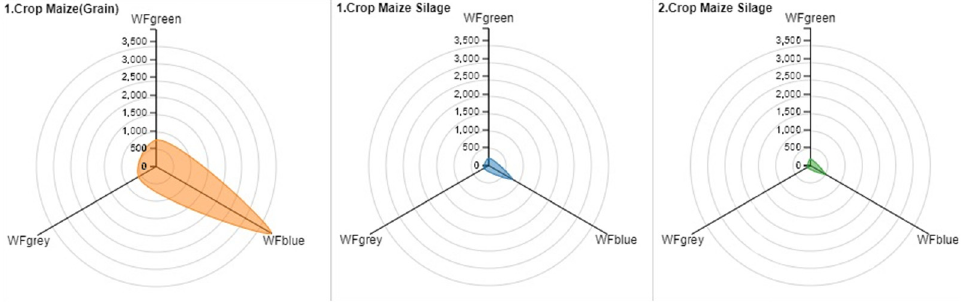
Figure 4. Three different components of the maize production WF. Swelam et al. [51] calculated the WFs of crops such as wheat and maize in different agro-climatic regions and determined the effects of climate on them. The results showed that the mean values of WF for maize were 1067, 1395 and 1655 m 3 /ton in old lands and 1395, 1634 and 2232 m 3 /ton in new lands under the three climate regions. When these results are compared with our obtained data, the first-crop silage maize is compatible with WF, whereas the first-crop maize WF is high in our study basin. The main reason for this is thought to be the preference for furrow irrigation systems and the lack of irrigation management in the Küçük Menderes